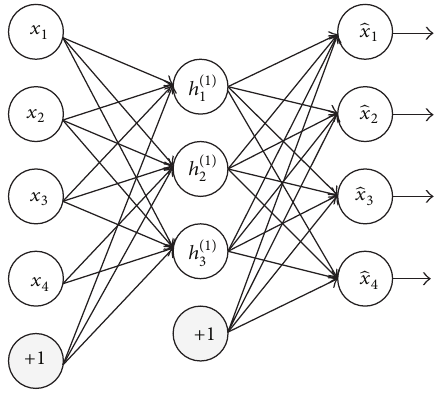
Figure 5: Structure of an autoencoder.